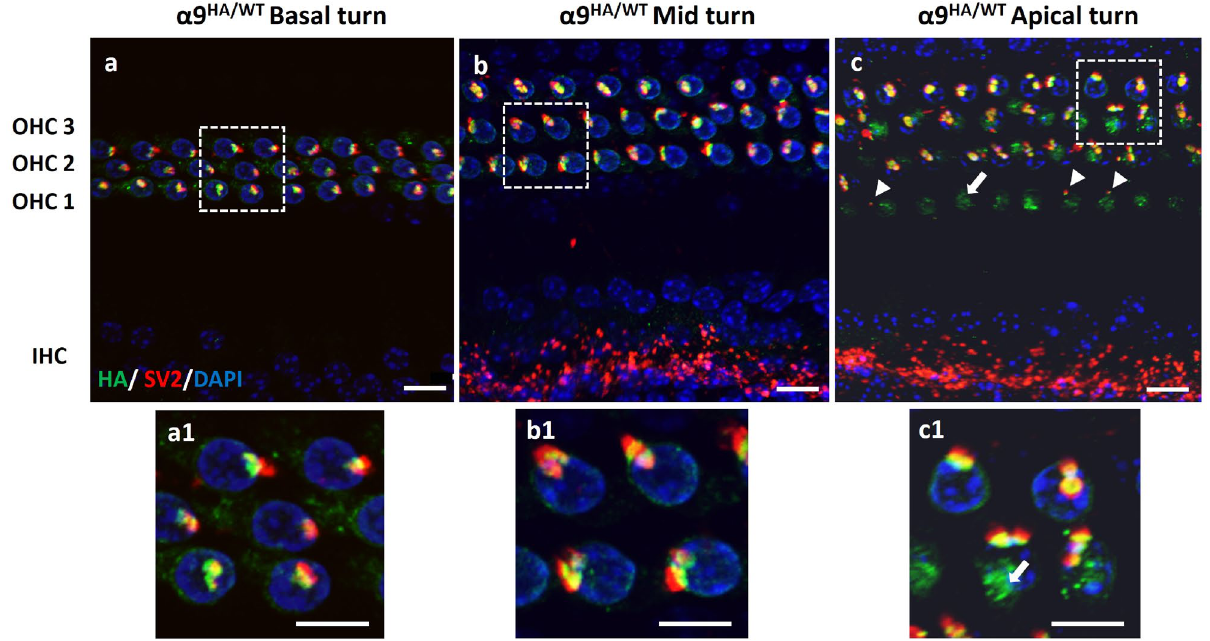
Corti with MOC terminal marker (SV2, red) and anti-HA tag antibodies (green). Along the sensory epithelium from basal to apical turn, OHCs exhibited postsynaptic α9HA immunoclusters (green) at their sub-nuclear